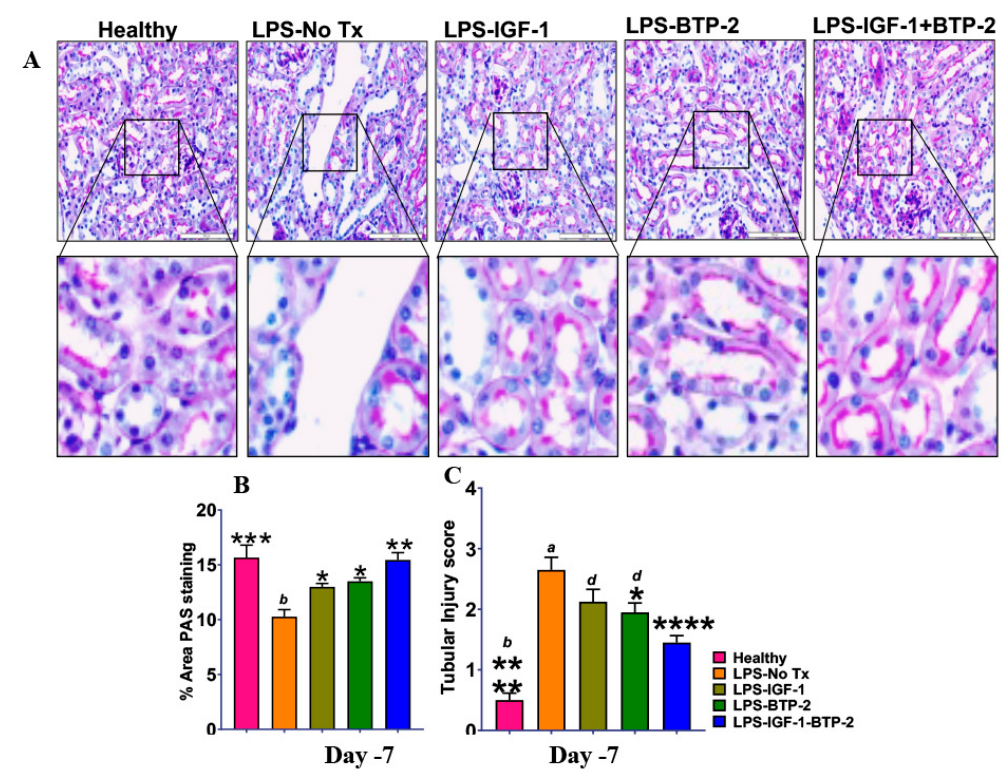
Figure 8. Effect of therapies on LPS induced acute tubular injury. ( A ) Periodic acid–Schiff (PAS) staining on day 7 of kidney injury (original magnification 40×; Scale bar, 100 µm). ( B ) % Area pf PAS staining. ( C ) Acute tubular injury score of mouse kidneys. Data are mean ± SEM * p < 0.05, ** p < 0.01, *** p < 0.001, **** p < 0.0001 (* LPS Vs other groups) and d - p < 0.05, c - p < 0.01, b - p < 0.001, a - p < 0.0001 (LPS + IGF1 + BTP-2 Vs other groups), 1-way ANOVA followed by a Dunnett’s multiple comparisons test, and unpaired t -test.